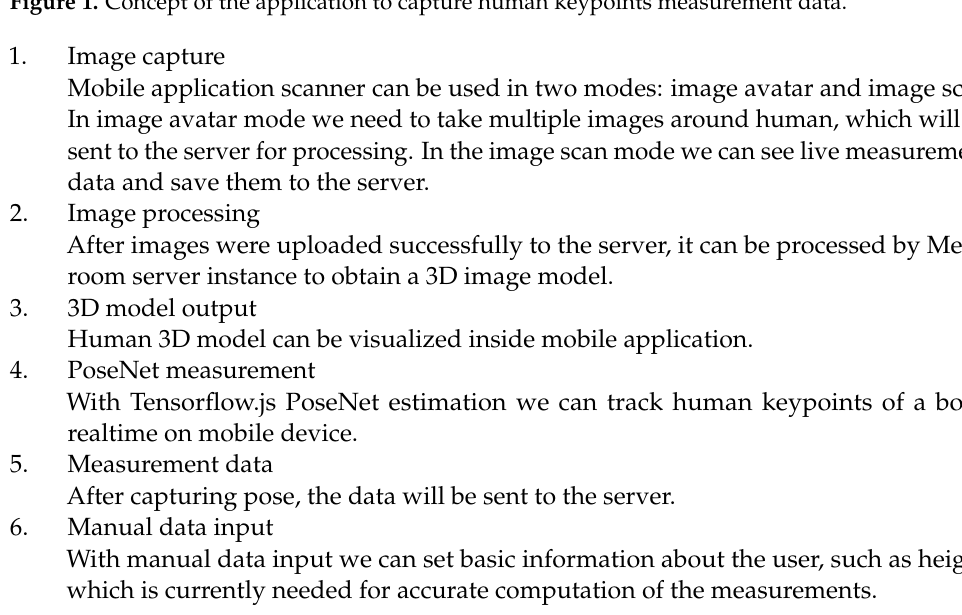
Figure 1. Concept of the application to capture human keypoints measurement